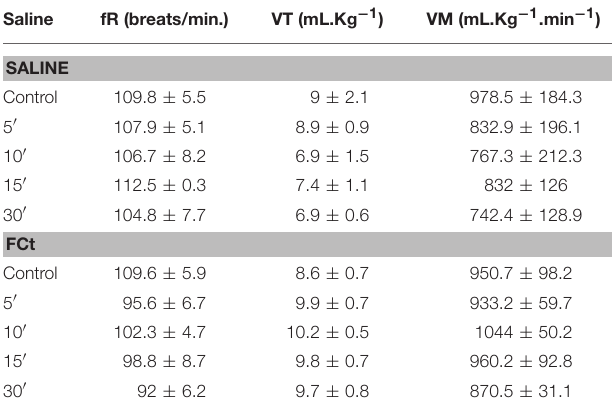
TABLE 2 | Changes in baseline fR, VT, and VM induced by icv ANG-II microinjections before (control) and 5, 10, 15, and 30min. Saline fR (breats/min.)